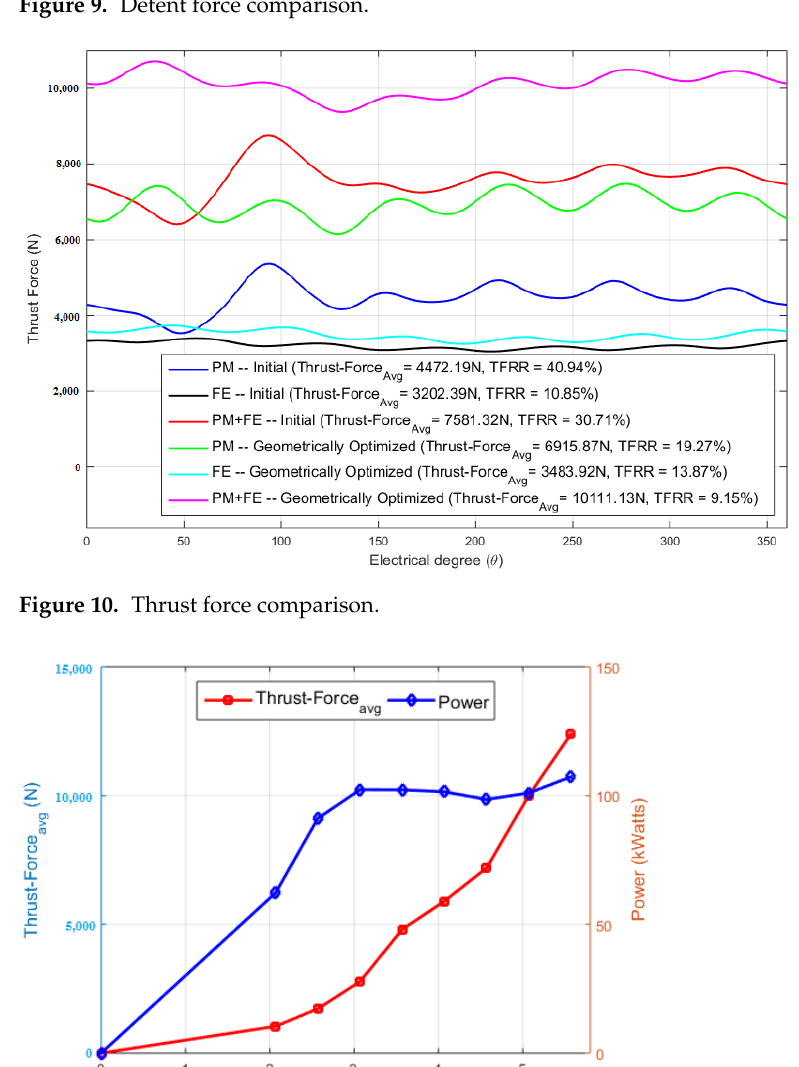
Figure 9. Detent force comparison.